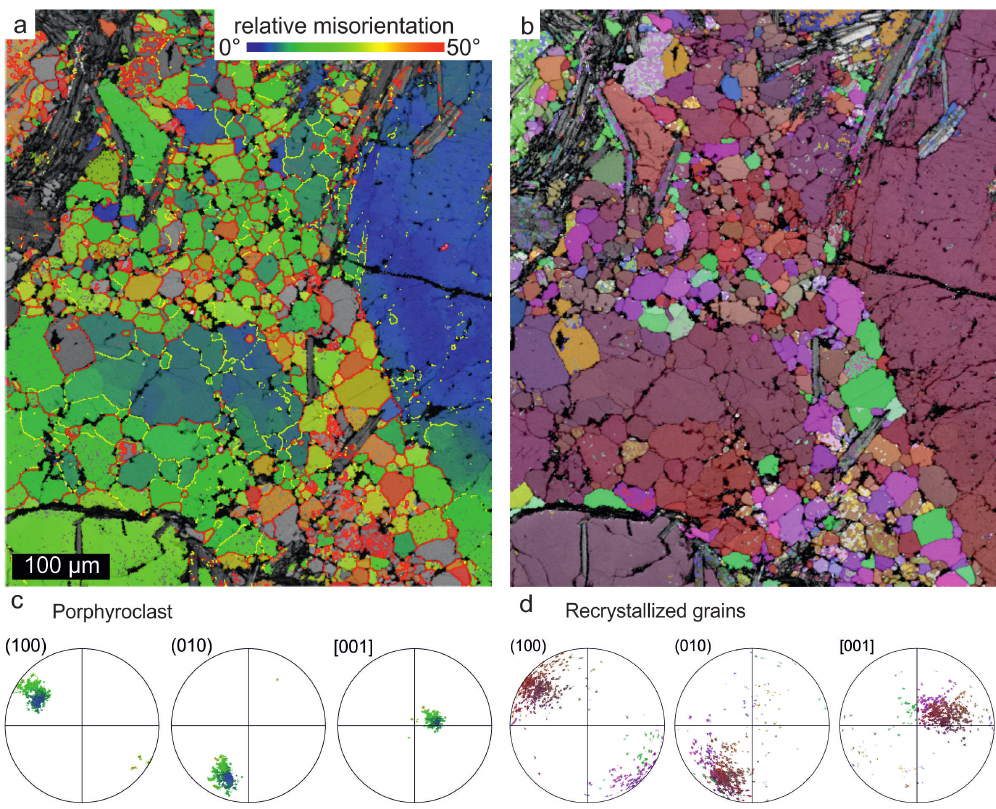
Fig. 4. EBSD data presented as maps colour-coded by (a) the relative misorientation and (b) orientation (Euler angles) showing partly recrys- tallized olivine porphyroclast (sample CT_07-13; compare Fig. 3f). Yellow lines in (a) represent low-angle grain boundaries (misorientation < 10 ◦ ); red lines represent high-angle grain boundaries (misorientation > 10 ◦ ). (c, d) Corresponding pole figures of poles to (100), (010) and (001) planes in an equal-angle projection of the lower hemisphere for porphyroclasts and recrystallized grains,